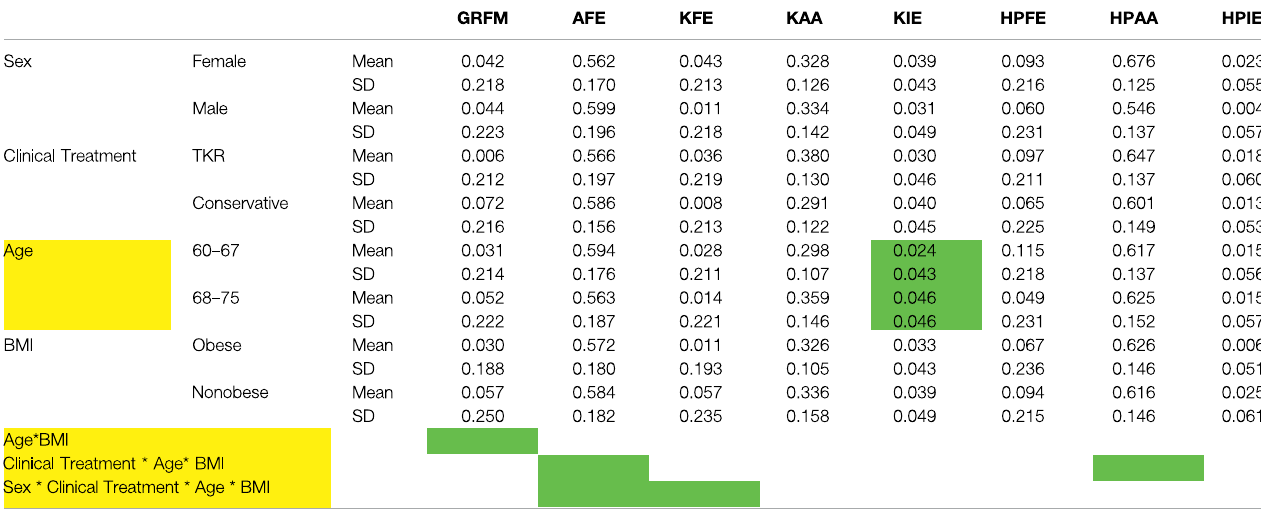
Frontiers in Bioengineering and Biotechnology |